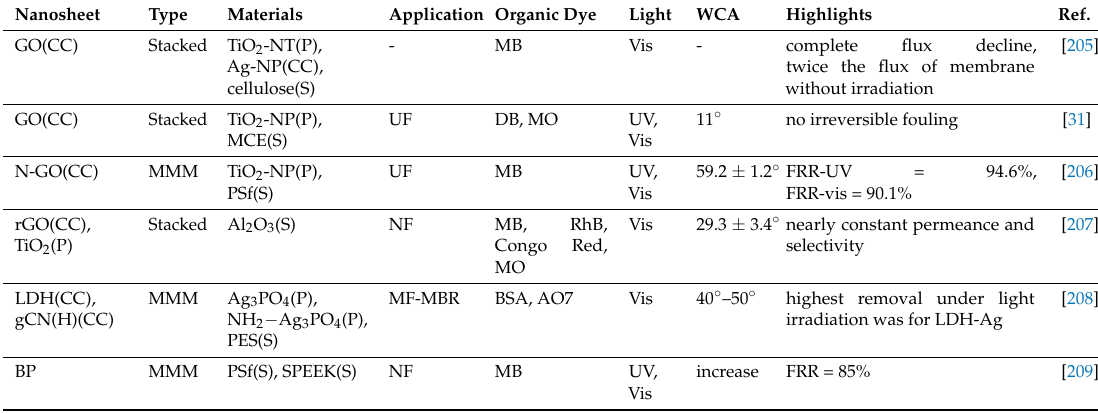
Table 2. Photocatalytic nanosheet membranes to mitigate non-migratory